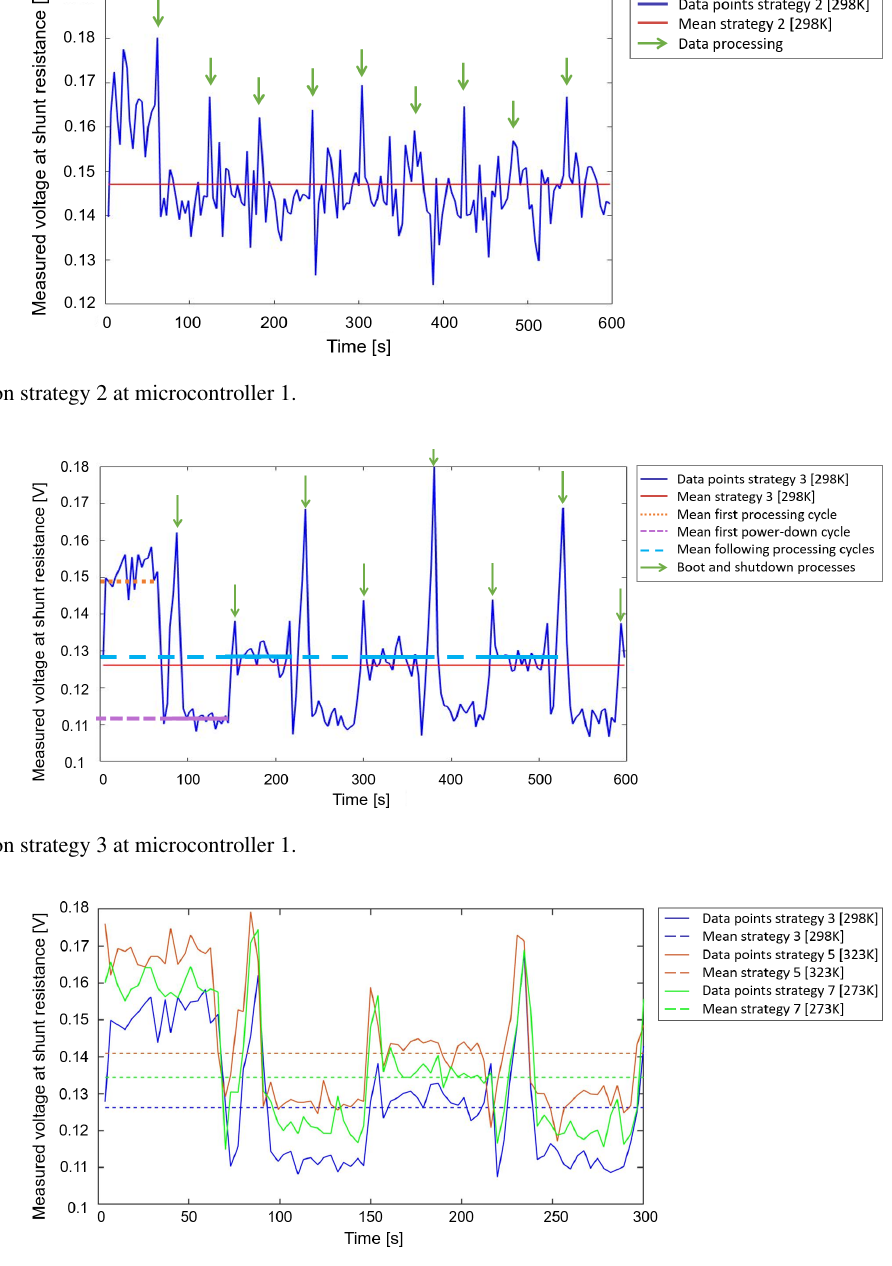
Figure 8. Comparison of the temperature-dependent strategies 3, 5 and 7.